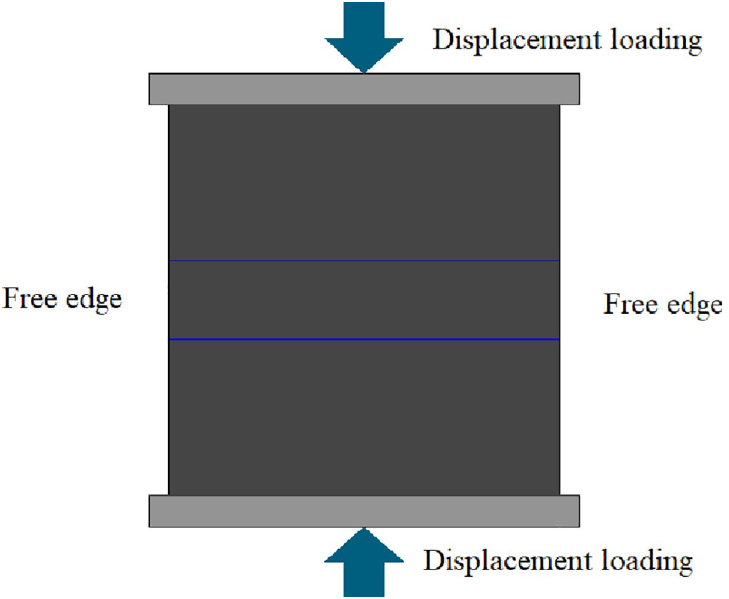
Fig 4. Uniaxial compression simulation loading method and boundary control model diagram.